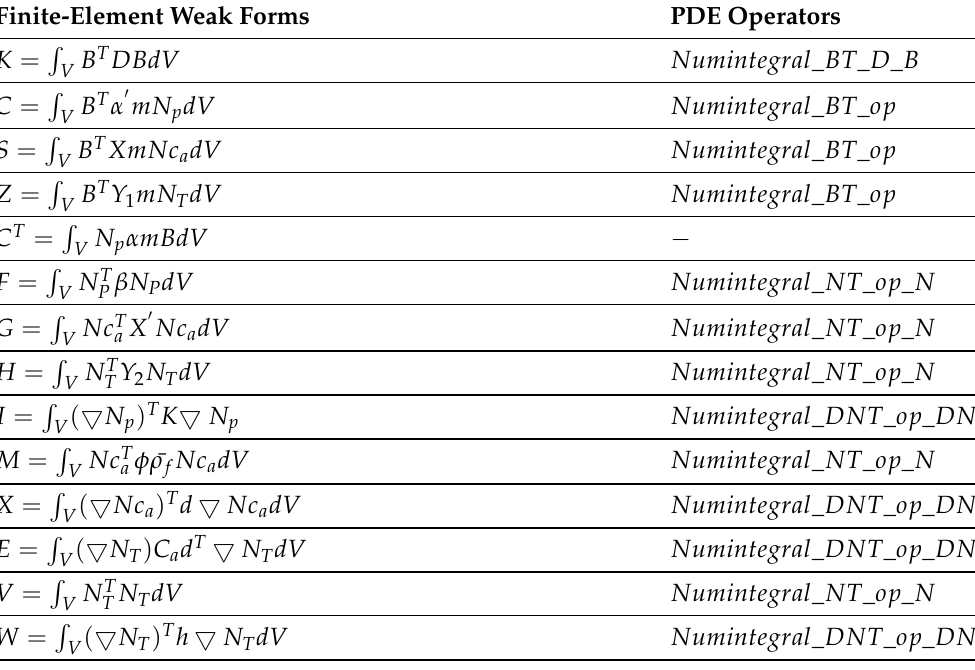
Table A1. Finite-Element Integral Matrices and Corresponding PDE Operators Applied in this Study.